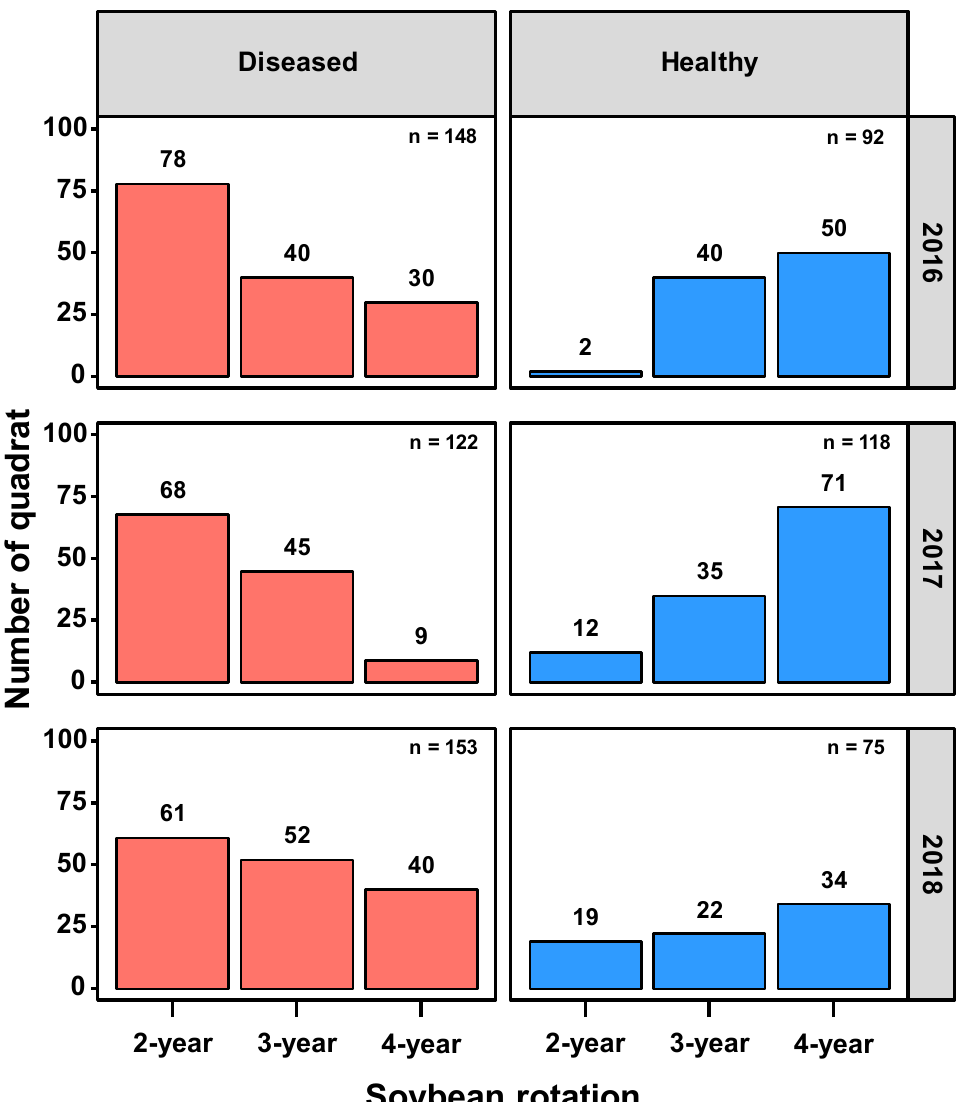
Figure 5. Frequencies of healthy and diseased quadrats in 2-, 3-, and 4-year soybean rotation plots at the end of the 2016 to 2018 soybean growing seasons. Quadrats with no foliar SDS symptoms and less than 5% foliar incidence were classified as healthy quadrats, and quadrats with foliar symptoms on more than 5% of the plants at the end of the season were classified as diseased quadrats. In 2018, 12 flooded soybean quadrats were omitted from data analysis.